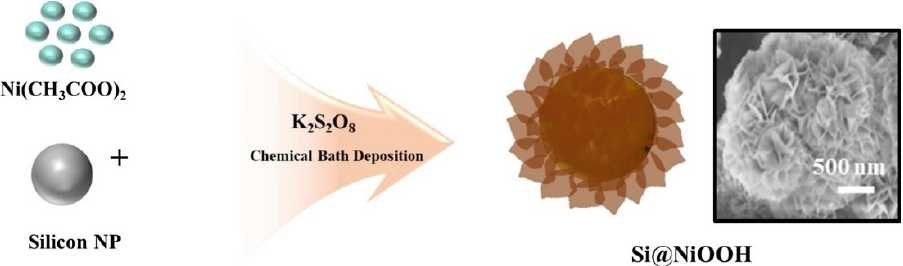
Figure 6. Schematic of Si@NiOOH prepared from Si particles and Ni(II) acetate. Reprinted with permission from Ref. [24]. Copyright 2021, Elsevier.